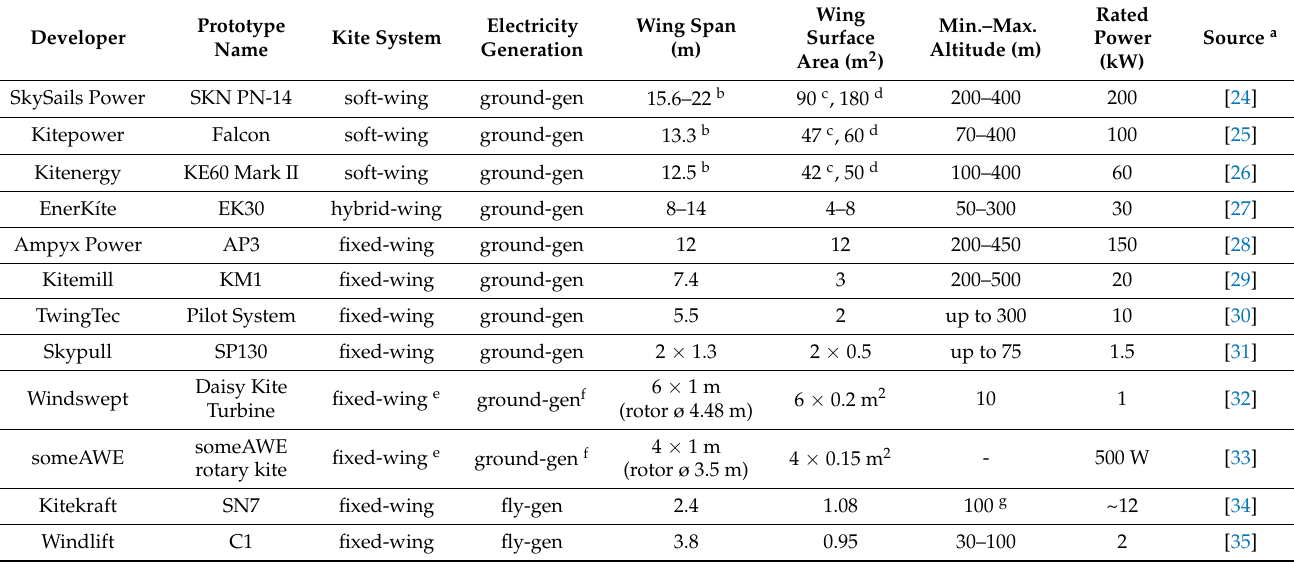
Table 1. Overview of the technical specifications of the tested prototypes of AWE